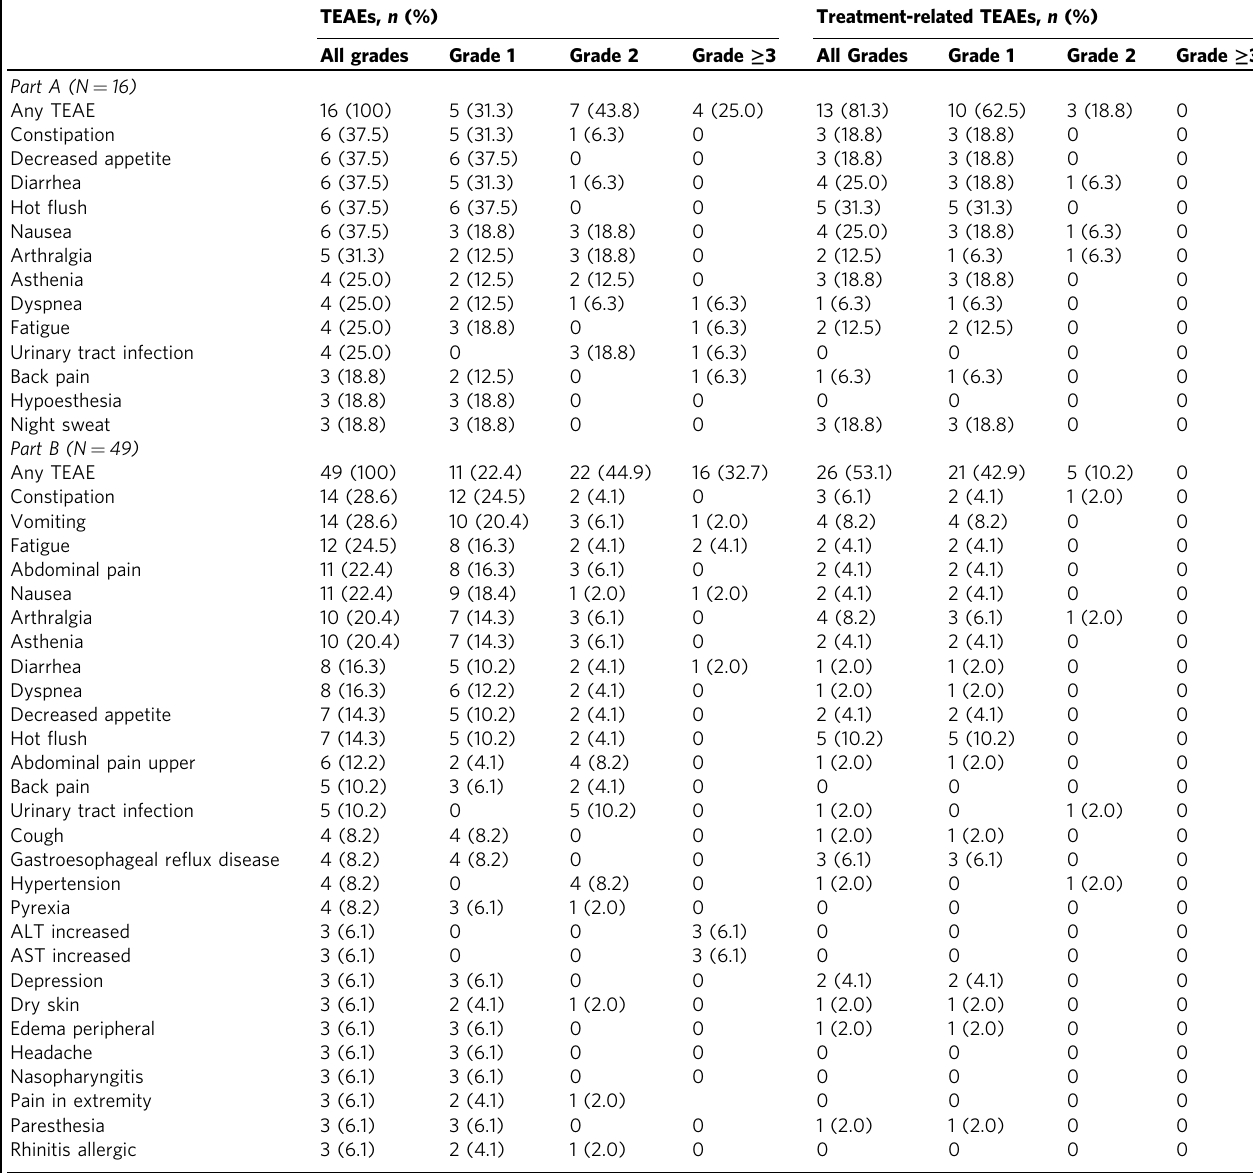
Table 3 Overview of adverse event pro fi le in Part A and Part B (patients with all TEAEs occurring in at least three patients and their associated treatment-related TEAEs) — safety